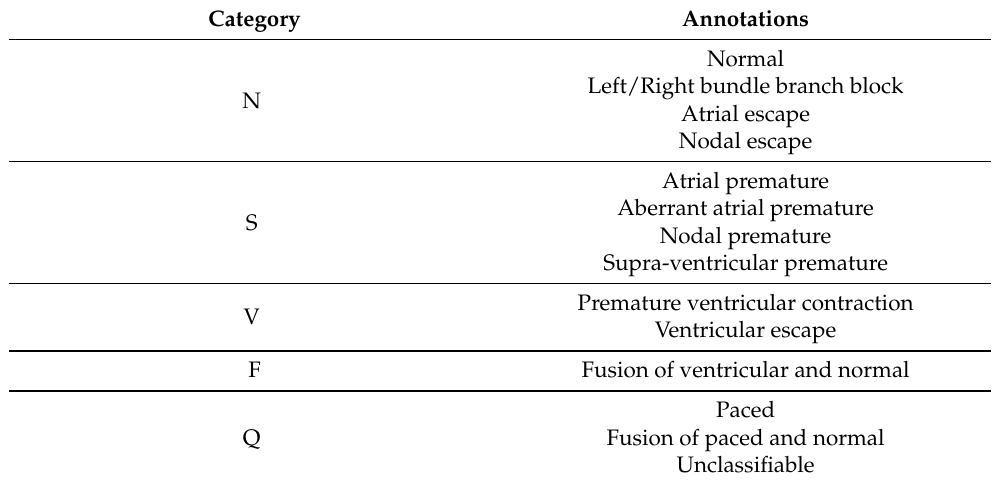
Table 1. Mappings between beat annotations and AAMI EC57 [51] categories.